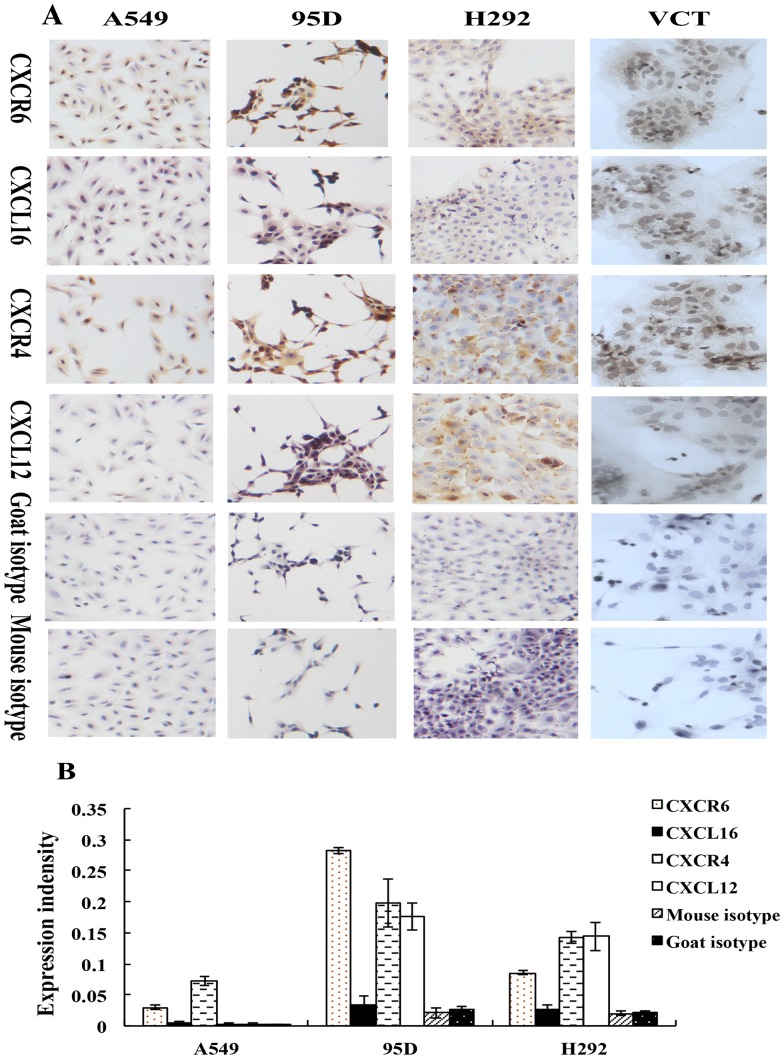
CXCL16-CXCR6 and CXCL12-CXCR4 proteins were co-expressed in human lung cancer cell lines in vitro.Immunocytochemistry was conducted to detect the protein expression of CXCL16-CXCR6 and CXCL12-CXCR4 in human lung cancer cell lines. The antibodies used in this experiments were mouse anti-human CXCR4 (25 µg/ml), mouse anti-human CXCR6 (25 µg/ml), mouse anti-human CXCL12 (20 µg/ml) and goat anti-human CXCL16 (20 µg/ml) antibodies. Positive brown-coloured staining for both CXCL16 and CXCR6 was clearly observed in the cytoplasm and cytomembrane of A549, H292 and 95D cells, respectively. Furthermore, CXCL12 and CXCR4 were also co-expressed in the three lung cancer cell lines. No background staining was observed in the isotype control. A: The images were representative of the experiments; B: The relative expression intensity of CXCL16-CXCR6 and CXCL12-CXCR4 in A549, H292 and 95D cells. Tro: human primary cultured trophoblast cells as a positive control. Magnification, ×200.